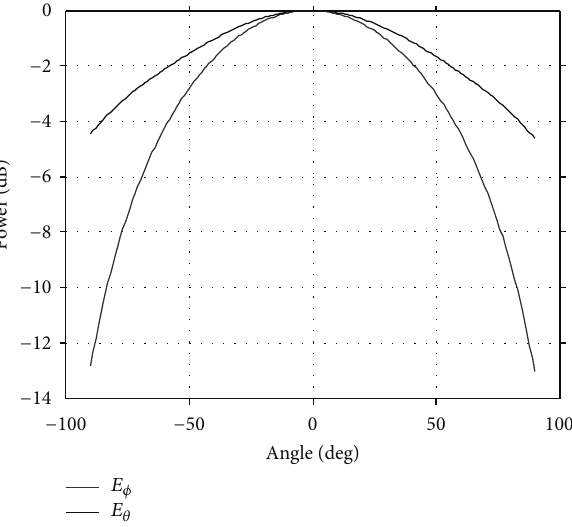
Figure 14: Radiation pattern of circular waveguide at 𝑟 = 0.5𝜆